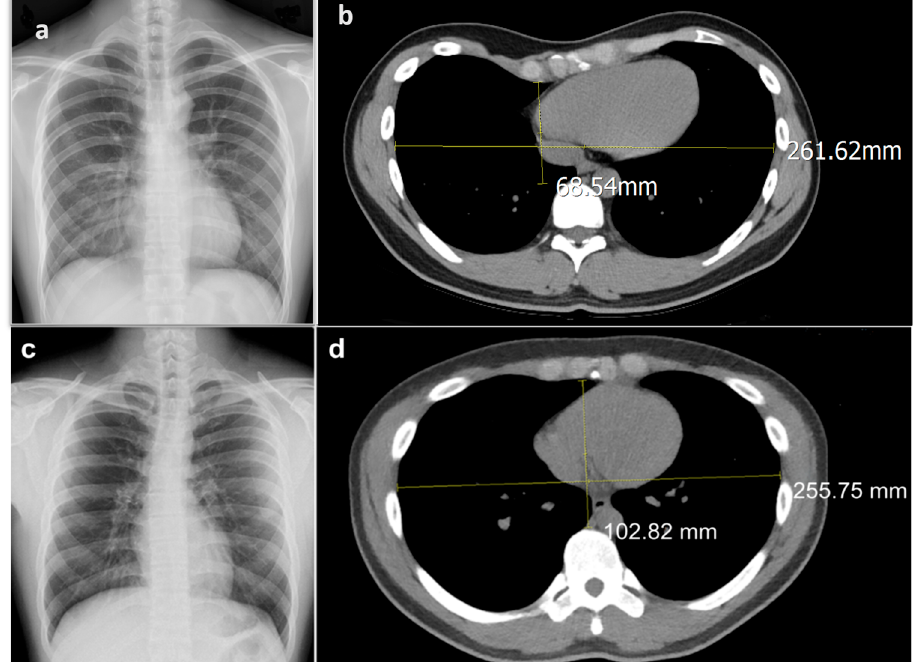
Figure 1. Pectus excavatum is diagnosed by Haller index >3.25. Calculation of Haller index by measurement of SVD (sternual-vertebral distance) divided by TD (transverse chest diameter) from chest computed tomography (CT). Sample images used in our study: ( a ) posteroanterior-view chest X-ray of a 24-year-old patient with PE with ( b ) CT calculated Haller index of 3.82. ( c ) Posteroanterior-view chest X-ray of a 24-year-old patient with no abnormal radiographic finding with ( d ) CT calculated Haller index of 2.49.